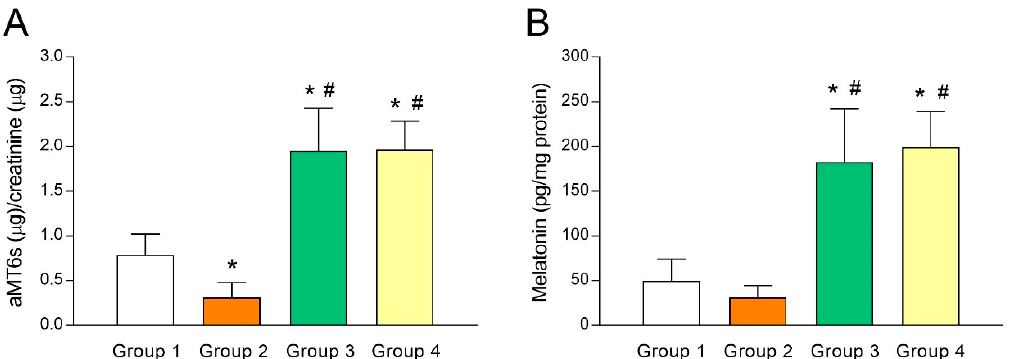
Figure 1. Melatonin levels in urine and follicular fluid of patients with unexplained infertility and the e ff ect of melatonin supplementation. Urinary levels of 6-sulfatoxymelatonin (aMT6s) ( A ) and intrafollicular concentrations of melatonin ( B ) in fertile women (group 1) and unexplained infertility (UI) patients untreated (group 2) or treated with 3 mg / day (group 3) or 6 mg / day (group 4) of melatonin. Values represent means ± SD of 10 individuals. * p < 0.05 vs . group 1. # p < 0.05 vs . group 2.